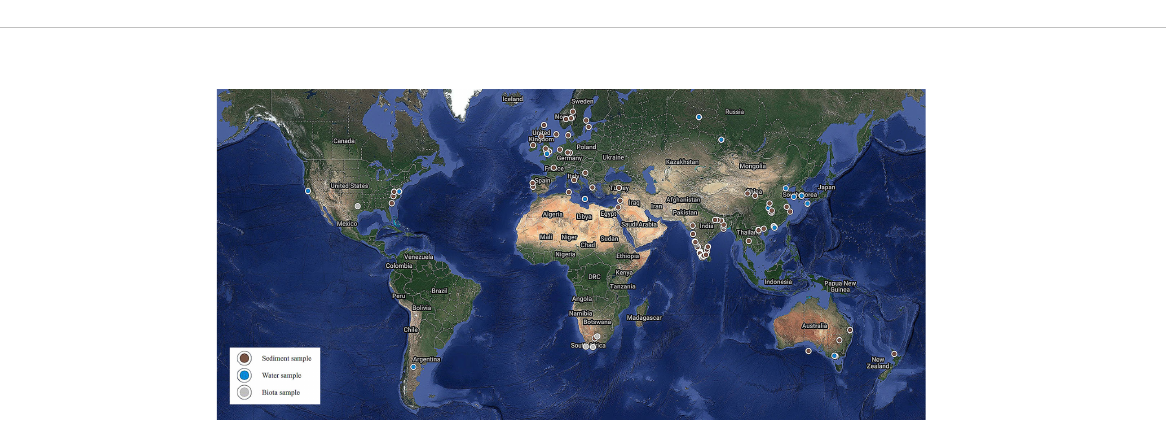
FIGURE 3 Map presenting the microplastic sampling in various areas outlined across the